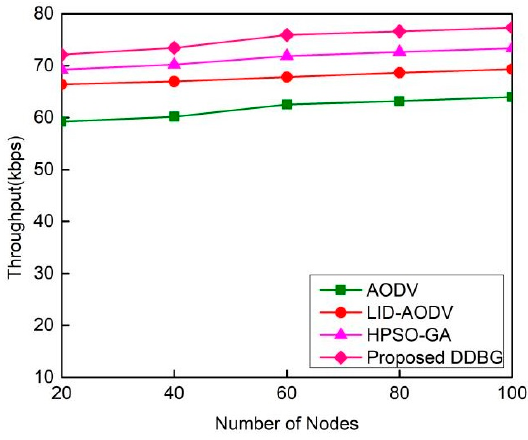
Table 6. The throughput evaluation values.